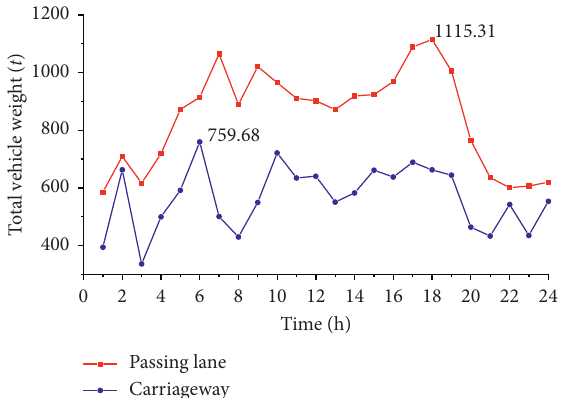
Figure 12: Extreme value of vehicle weight in hours.